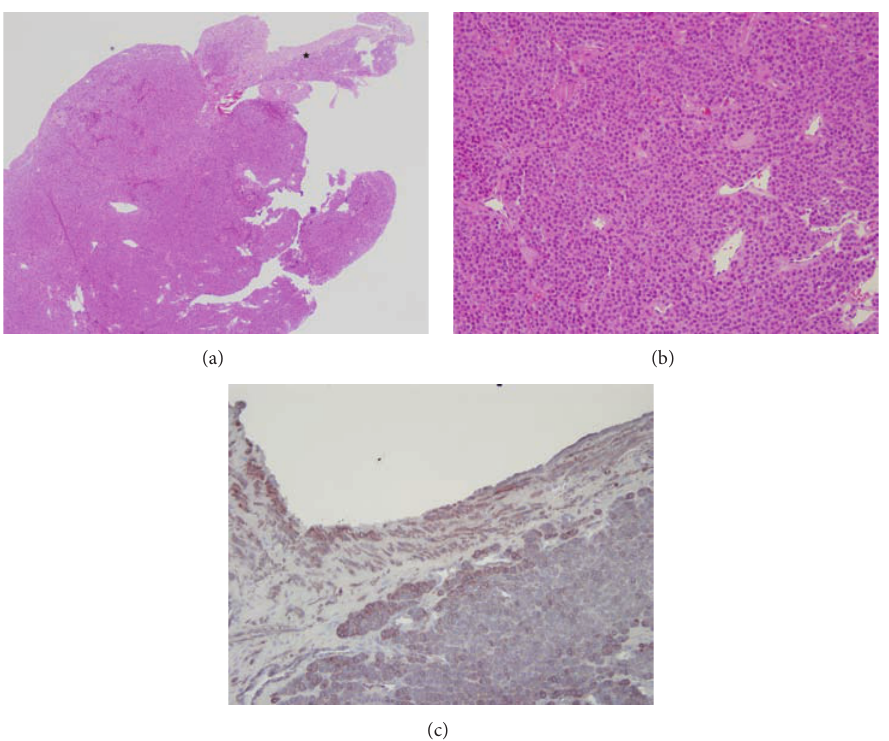
Figure 3: (a) Histopathology slide of the specimen with hematoxylin and eosin staining at 40x magnification shows glomus tumor cells adjacent to the vessel wall (asterisk). (b) The tumor consists of uniformly rounded cells with centrally located round nuclei, eosinophilic cytoplasm, and dilated capillary vessels (200x magnification). (c) The tumor glomus cells and the smooth muscle cells of the vein wall stained for smooth muscle